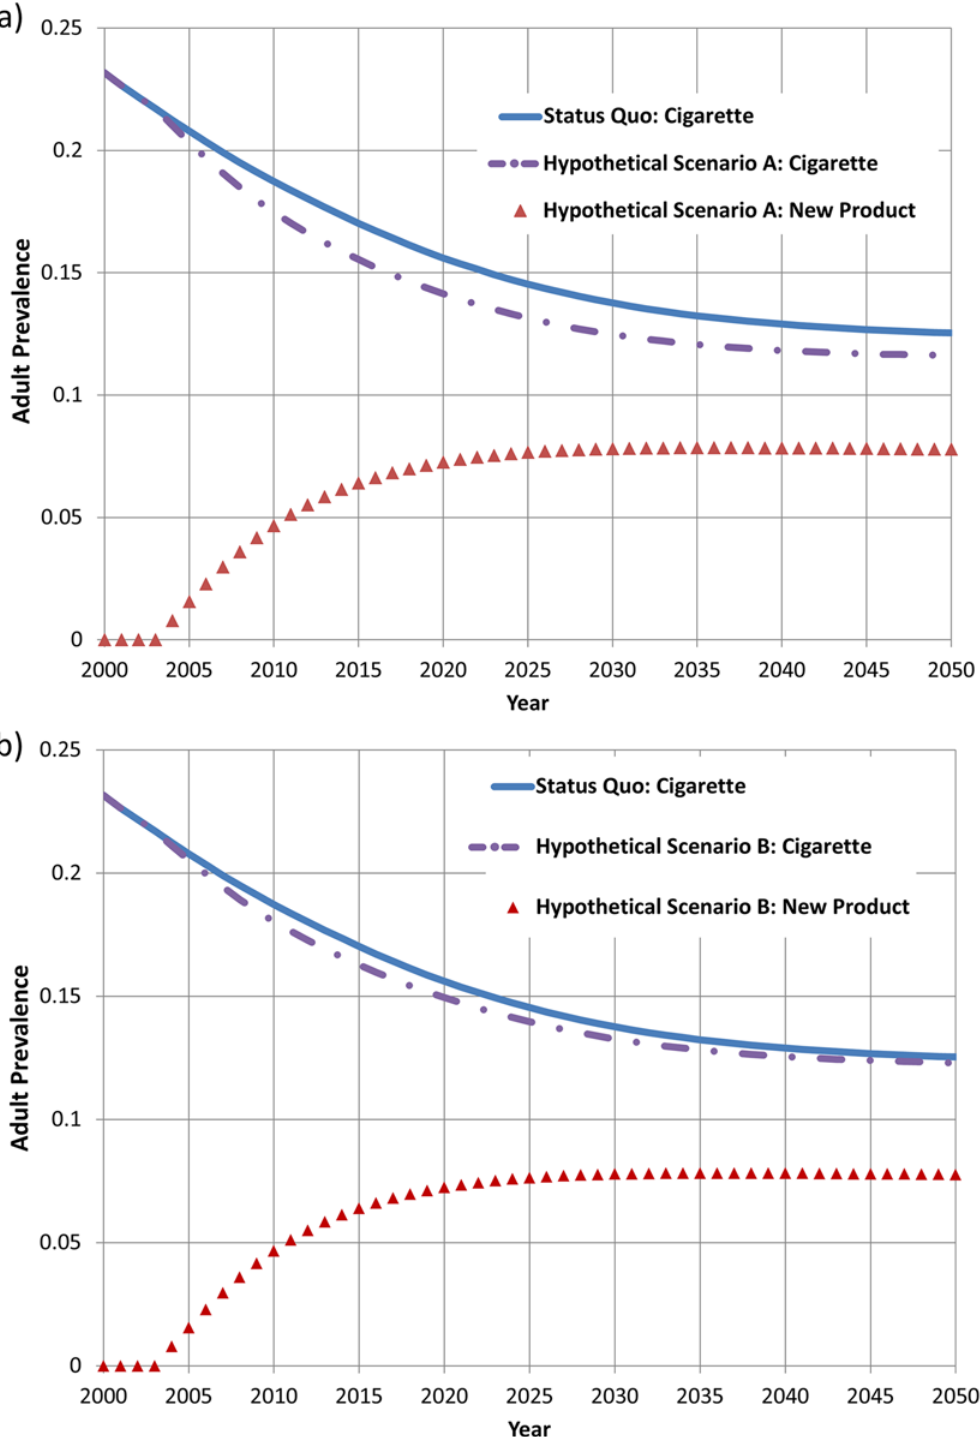
Fig 4. Comparison of cigarette smoking and new product use prevalence in status quo and hypothetical scenarios: (a) hypothetical scenario A, in which annual transition rates among smokers are 1.5% for dual use and switching (b) hypothetical scenario B, in which annual transition rates among smokers are 2% for dual use and 1% for